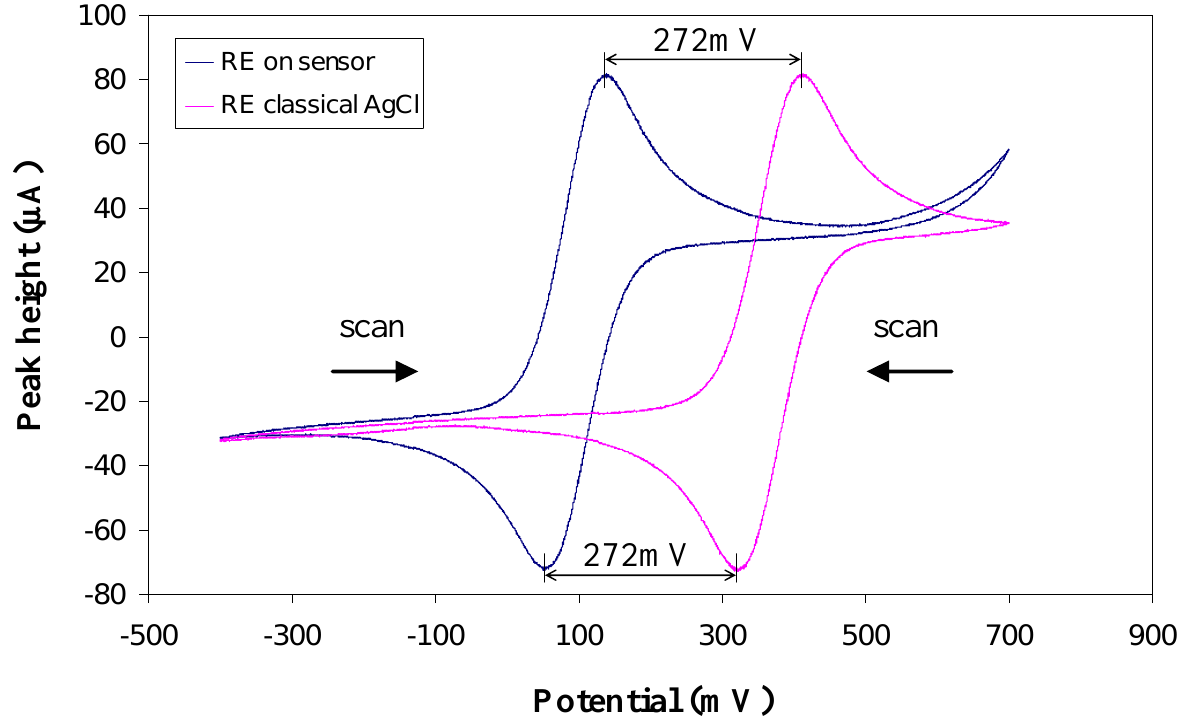
Figure 2. Calibration of TFT reference electrode against saturated Ag/AgCl